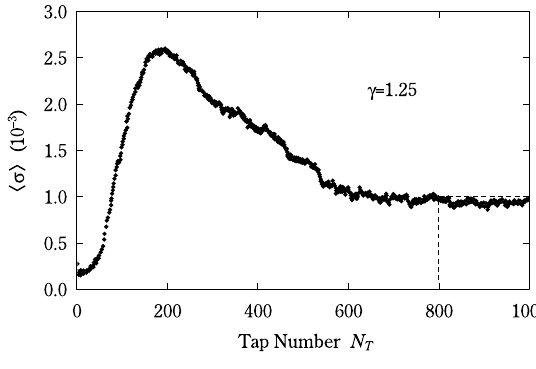
Fig. 3 Standard deviation of the bulk solids fraction 〈σ ( n ; γ ) 〉 versus tap number N T at tap intensity γ＝ 1.25 for 100 realizations. This demonstrates the convergence properties of the methodology.